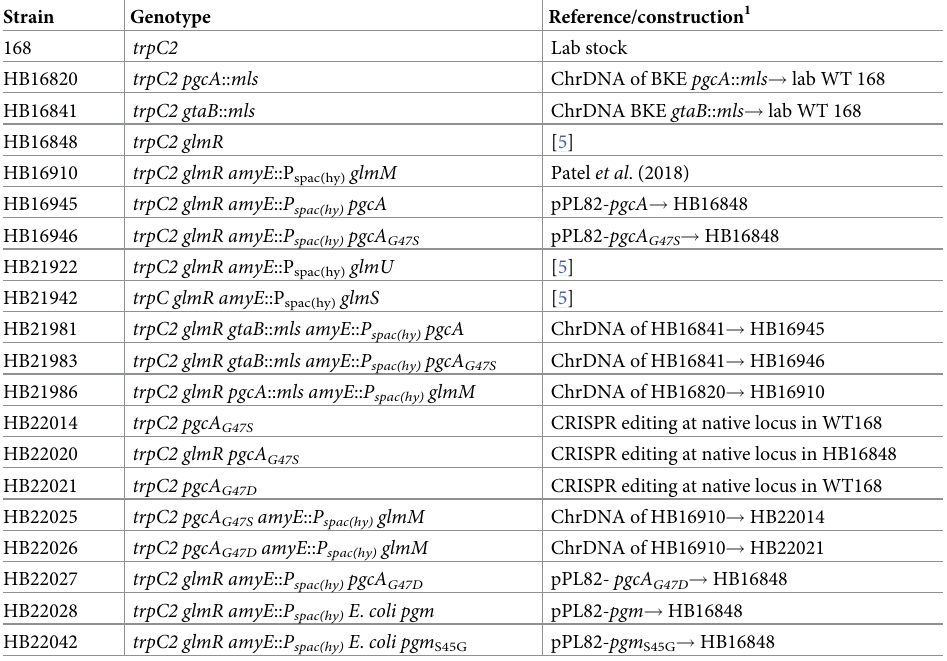
Table 4. B . subtilis strains used in this study. Strain